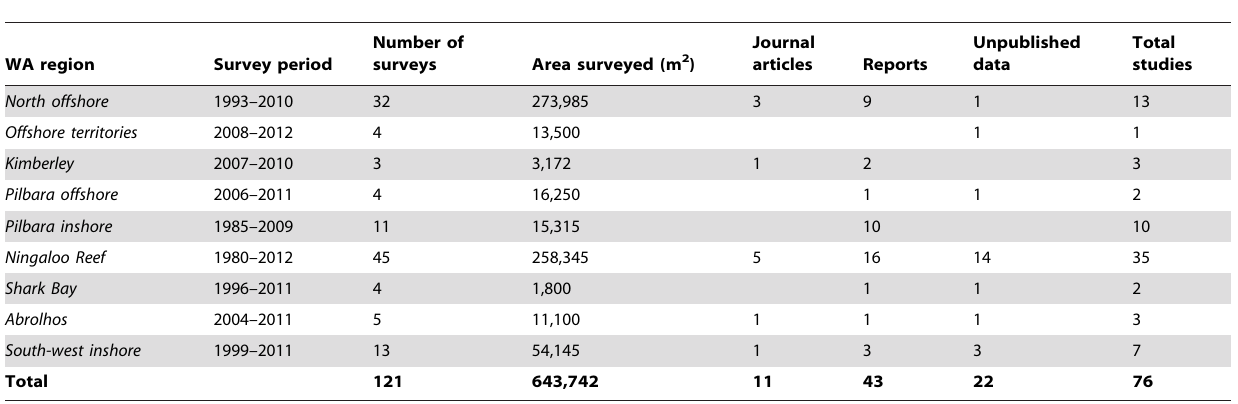
Table 1. Summary of data sourced for meta-analysis in our